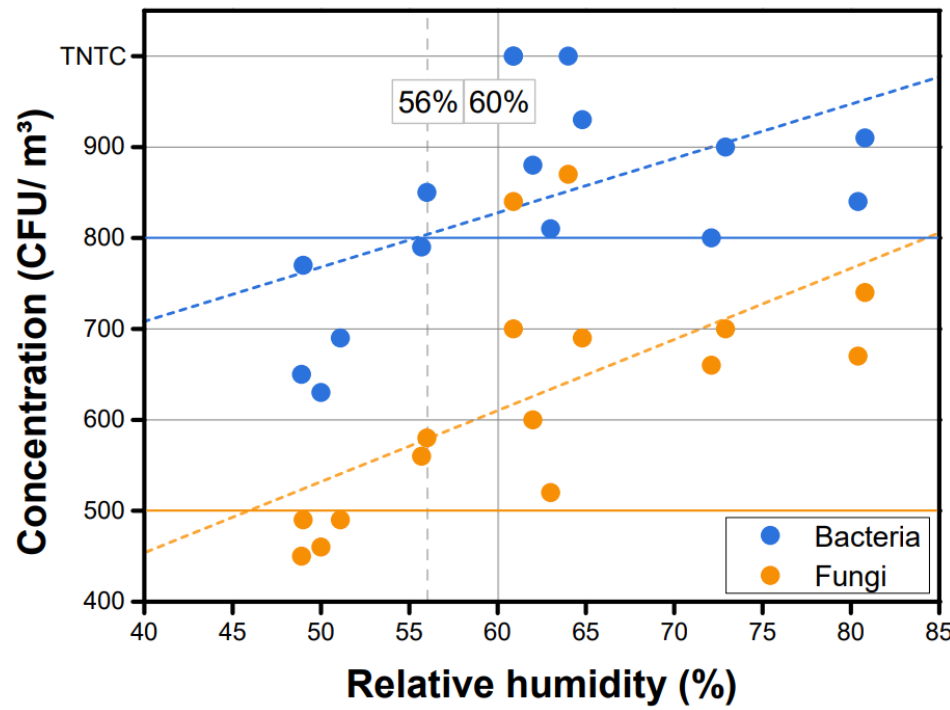
Figure 3. Concentrations of airborne microorganisms with respect to relative humidity.